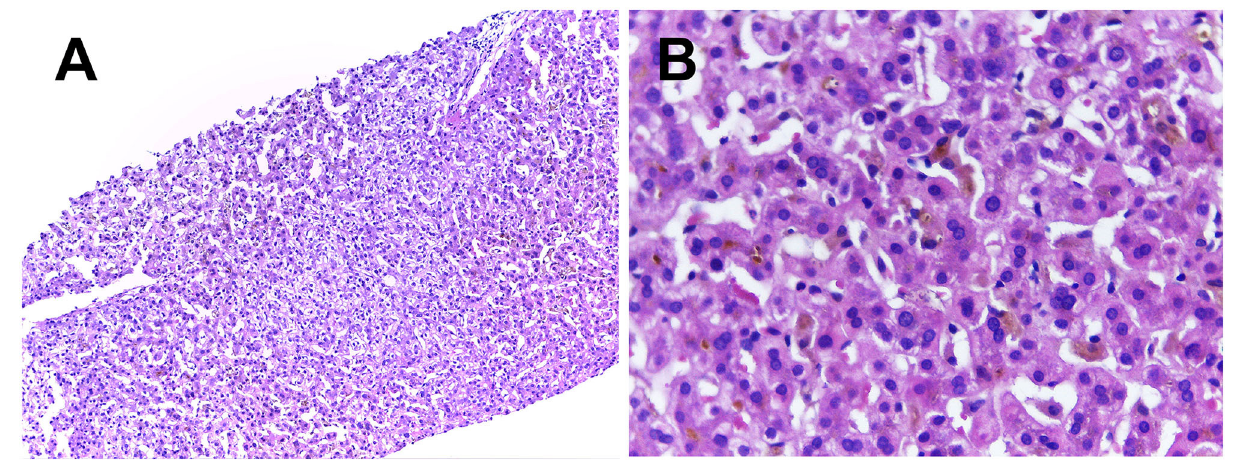
FIGURE 1 | Liver histology showed normal lobular architecture with few lymphocytes, monocytes and neutrophils infiltrating the portal areas were seen in (A) (H&E × 100). Extensive cholestasis of hepatocytes and the formation of bile embolism were better observed at a higher magnification in the centrilobular zone 3 on (B) (H&E ×